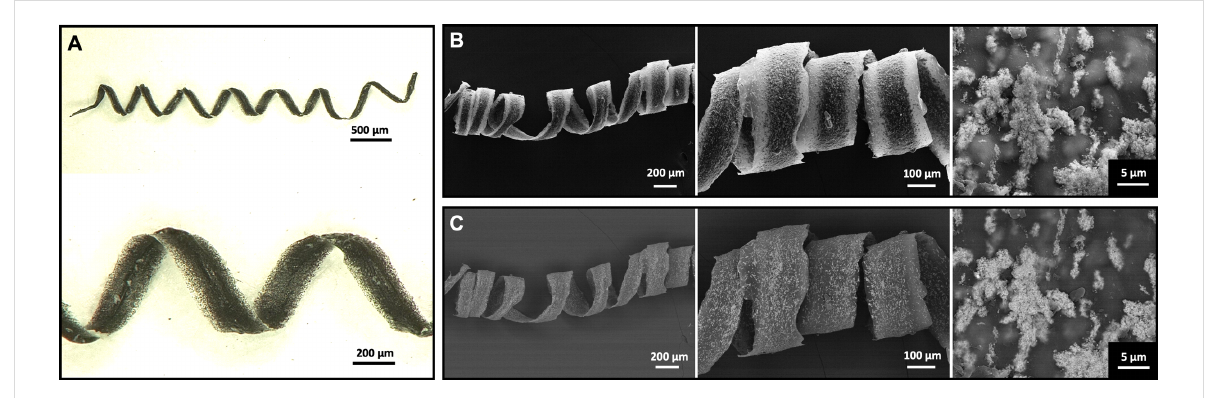
Figure 3: Helical IOP-embedded chitosan microfibers were prepared by wet-spinning and manual winding. (A) A representative light microscopy image shows that the helical fibers have a flat surface. (B) SEM images obtained from the secondary electron detector (left and middle panel) reveal a fiber diameter of approximately 130 µm and a higher magnification image confirms the coagulation-driven IOP agglomeration in the chitosan fibers (right panel). (C) SEM images obtained from the backscattered electrons show the difference in material contrast between the chitosan matrix and embedded IOPs at different